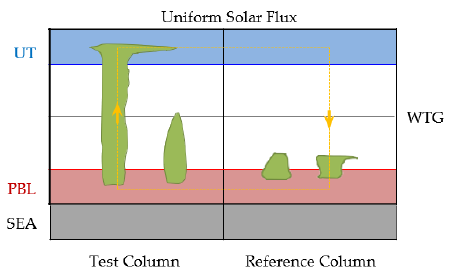
Figure 10. Schematic showing (green area) the deep and shallow convective clouds in two adjacent columns are connected by (golden line) a large-scale vertical circulation. The two columns maintain the WTG in the mid-troposphere, and each column is characterized with the three layers of (blue) the UT, (red) PBL and (gray area) sea surface. Deep convective clouds decrease the entropy in the PBL via their downdrafts. Some of the downdrafts penetrate into the PBL (Figure 8) and, thus, bring the mid- tropospheric air with the minimum entropy s min into the PBL (Figure 7). As a result, the vertical entropy flux from the lower troposphere to the PBL is proportional to ∆𝑠 𝑠 + 𝑠 𝑠0 − 𝑠 𝑚𝑖𝑛 . Since the deviation of the deep convective clouds from the RCE is propor- tional to w m , the deviation of the vertical entropy flux from the lower troposphere to the PBL is also proportional to w m . Hence, the entropy budget of the PBL is expressed as (18) where the three terms on the right-hand side, in turn, correspond to the entropy flux from sea, the horizontal entropy flux from the reference column and the vertical entropy flux from the lower troposphere to PBL. U s represents the horizontal wind speed of en- vironmental air in PBL with respect to the test column. The dimensionless coefficient k d represents the effect of the downdrafts on the surface entropy. Deep convective clouds transport the surface air with high entropy into UT and consequently increase the entropy. Hence, the entropy budget of the UT layer is ex- pressed as (19) where the three terms on the right-hand side, in turn, correspond to the horizontal en- tropy flux from the reference column, the upward entropy flux from the PBL and the en- tropy flux to space via infrared radiation. U u represents the UT horizontal wind speed of the environmental air with respect to the test column, and the dimensionless coefficient k u represents the effect of deep convective cores on the UT entropy. σ is the Stefan – Boltzmann constant, T u is the UT temperature, p m / p t are the pressure of the mid-